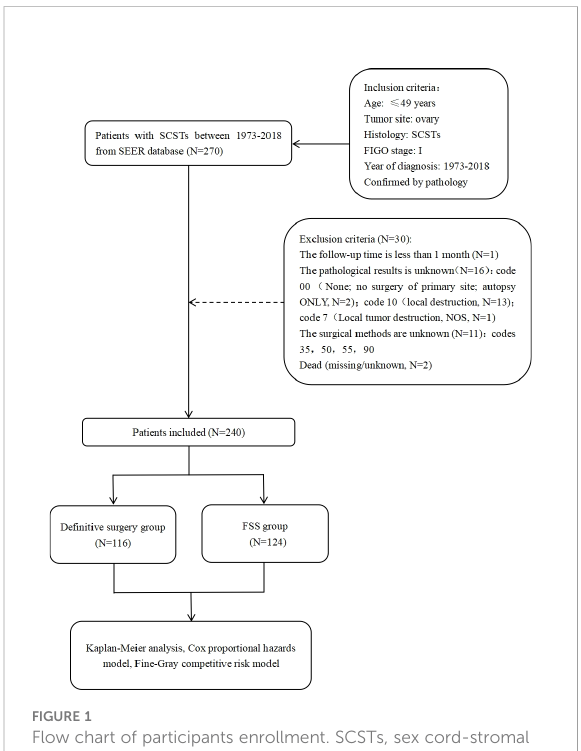
FIGURE 1 Flow chart of participants enrollment. SCSTs, sex cord-stromal tumors; FIGO, International Federation of Gynecology and Obstetrics; NOS, not otherwise speci fi ed; FSS,